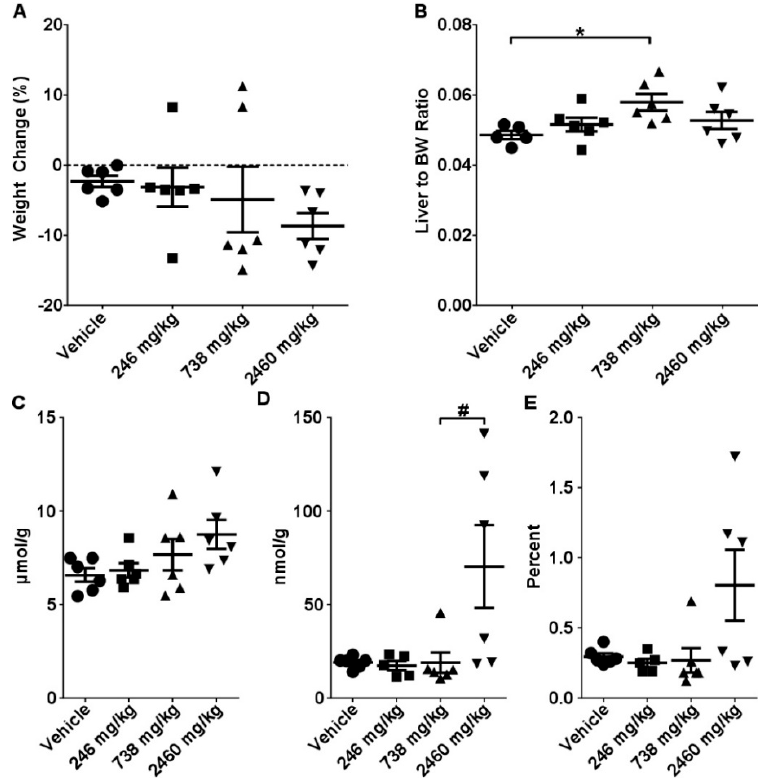
Figure 1. Effects of single gavage with CBD . Mice were gavaged with 246, 738, or 2460 mg/kg of CBD in sesame oil with tissues harvested at 24 h. ( A ) Body weight change, ( B ) liver to body weight ratios, intrahepatic concentrations of ( C ) total glutathione (GSH), ( D ) reduced glutathione (GSSG), and ( E ) GSH/GSSG ratio. Data are presented as mean ± SEM ( n = 6). * indicates a significant difference as calculated with a One ‐ Way ANOVA and Tukey’s post ‐ hoc test, and # indicates a significant difference as calculated with a Kruskal ‐ Wallis test with a Dunn’s post ‐ hoc test ( p < 0.05).